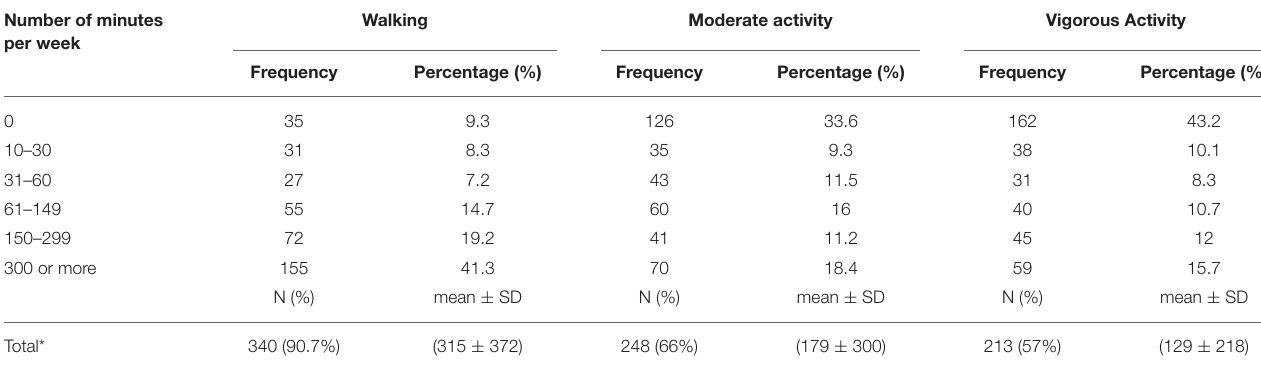
TABLE 4 | Proportions (%) of participants who engaged in walking, moderate, and vigorous physical activity over the past 7 days. Number of minutes per week